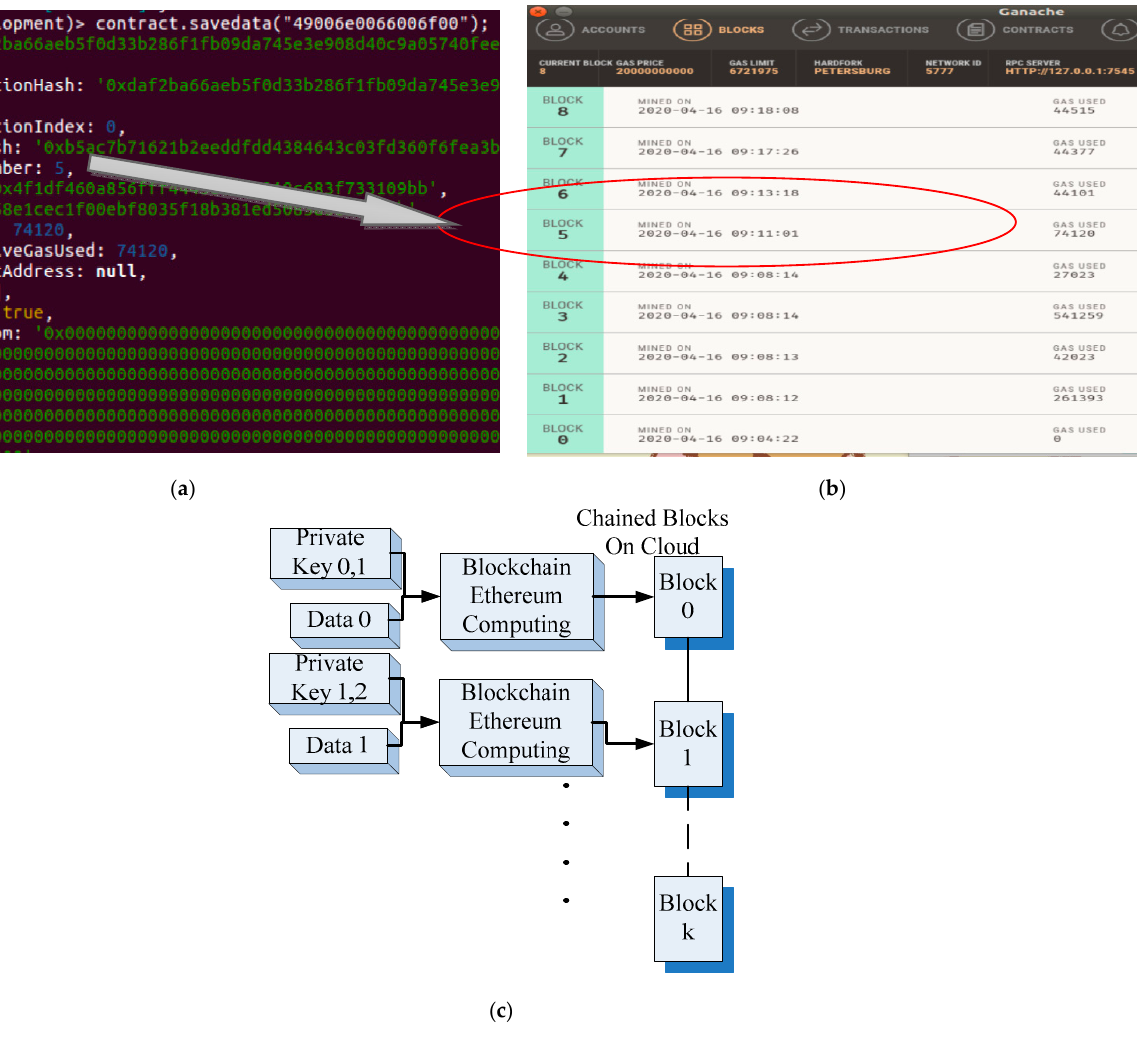
Figure 4. ( a ) Plaintext of the relevant object’s private key. This plaintext comprises the number sequence in TX that is included in the smart contract. ( b ) Blockchain data stored on the cloud platform after blockchain application. ( c ) Abstract concept of the proposed system blocking the plaintext or data by using the relevant private